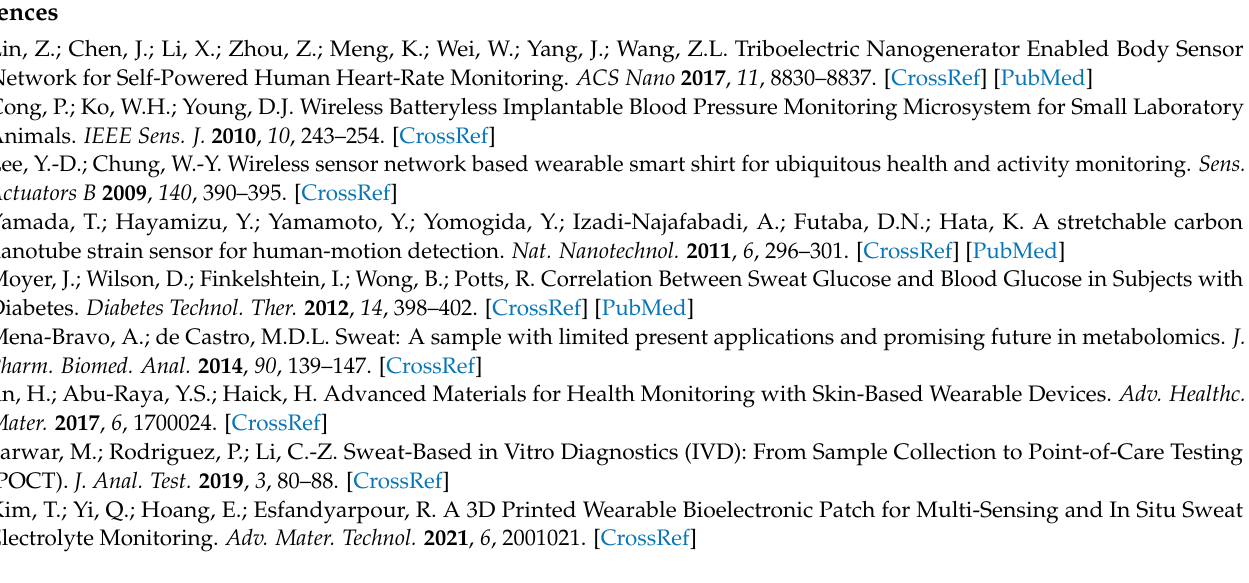
Figure S2: pH-, Na + -, and K + -sensing performance under normal and bent states, Figure S3: pH-, Na + -, and K + -sensing performance tested on the custom-developed wearable multiplexed sensing system, Table S1: The patterning of 2 × 2 cm squares on PI substrate, Table S2: Comparison of sensing performances, Video S1: On-body real-time testing process. References [48–56] are cited in the supplementary